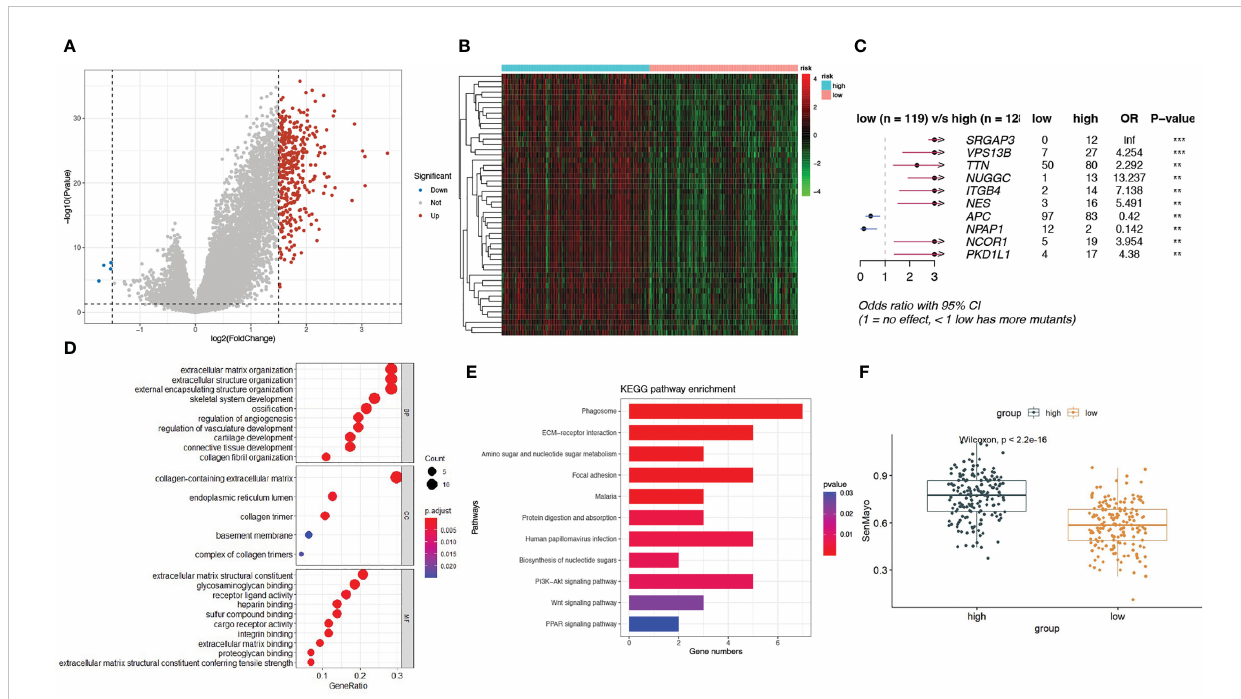
FIGURE 3 A landscape of different expressed genes and mutations in high-risk and low-risk subgroups. (A) Volcano plots of differentially expressed genes (DEGs) between high-risk and low-risk patients; (B) Heatmap of the expression of top 50 DEGs in the two subgroups; (C) The differentially mutated SenMayo genes between the two groups; (D) The GO enrichment pathways of DEGs; (E) The KEGG enrichment pathways of DEGs; (F) Comparison of SenMayo enrichment score between two subgroups.